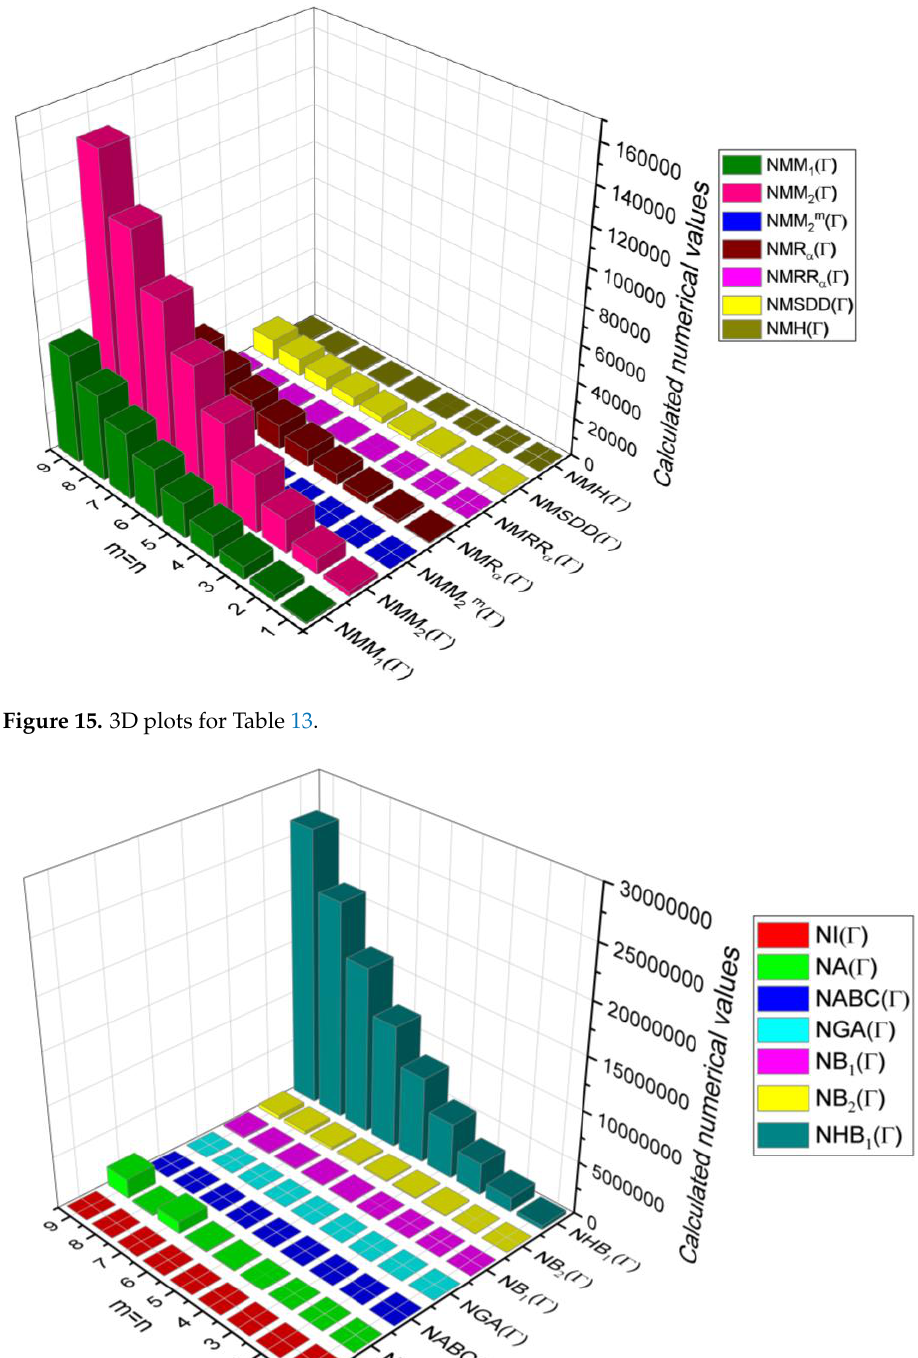
Figure 16. 3D plots for Table 14. Table 13. Comparison Table for Theorem 8.